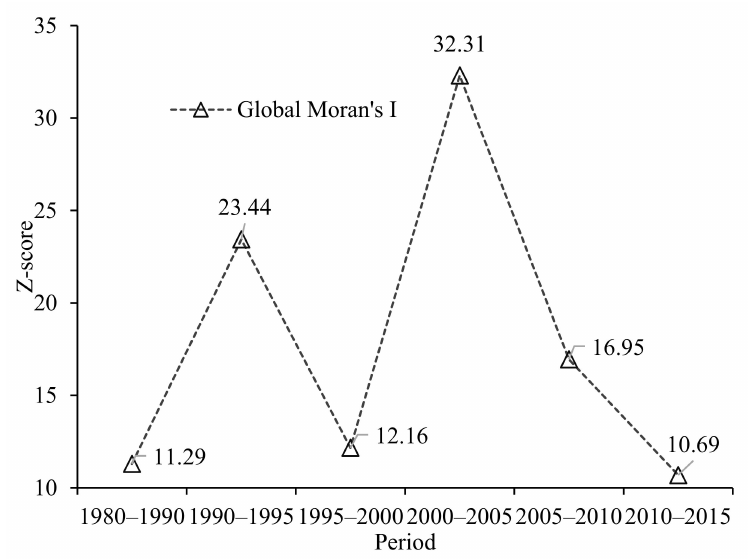
Figure 5. The degree of forest’s clustering in the timing of forest dynamics within GHKM from 1980 to